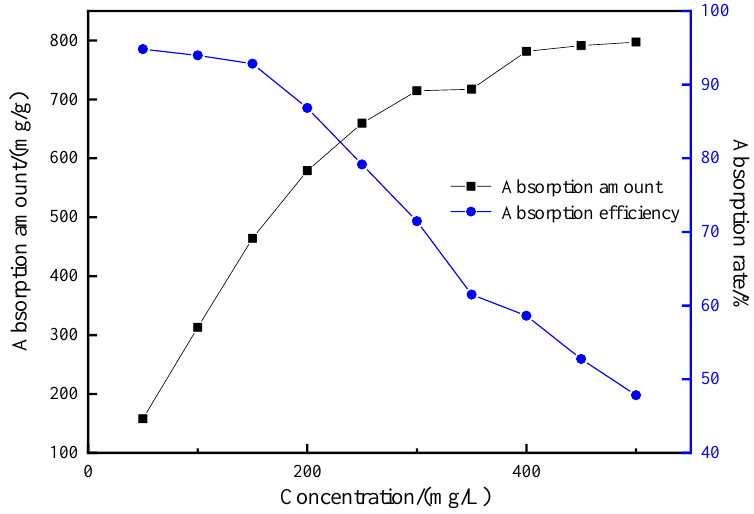
Figure 15. The influence of the initial mass concentration of adsorbate on the adsorption effect.